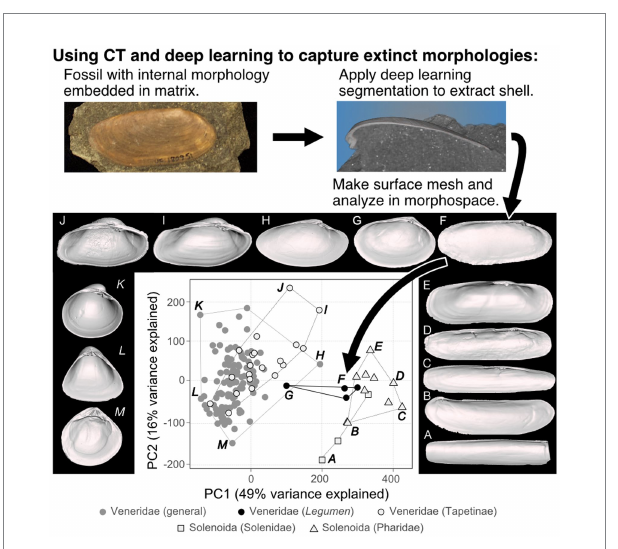
FIGURE 5 Using CT data to capture and analyze extinct morphologies. Fossils embedded in sediment, such as the Legumen ellipticum Conrad 1858 photographed here, can be micro-CT scanned and segmented from matrix using the deep learning approach from Figure 3. This analysis showed that the venerid genus Legumen (F, G), which was lost at the end-Cretaceous mass extinction, had an atypical shape that has yet to evolve again within the family (adapted from Collins et al.,